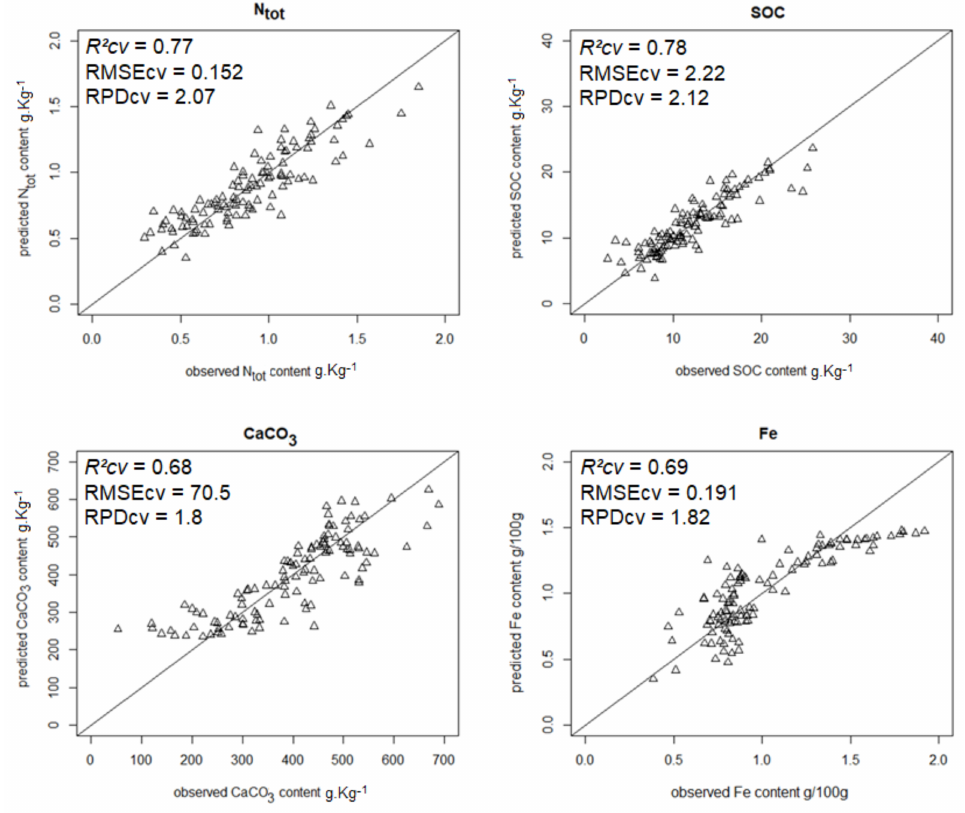
Figure 8. Scatterplots of predicted vs. observed topsoil N tot, SOC, CaCO 3 , and Fe contents from simple linear regression models (N tot and SOC: from SFR_R_mx ; CaCO 3 and Fe: from RR_R_mx and GR_G_mx ,